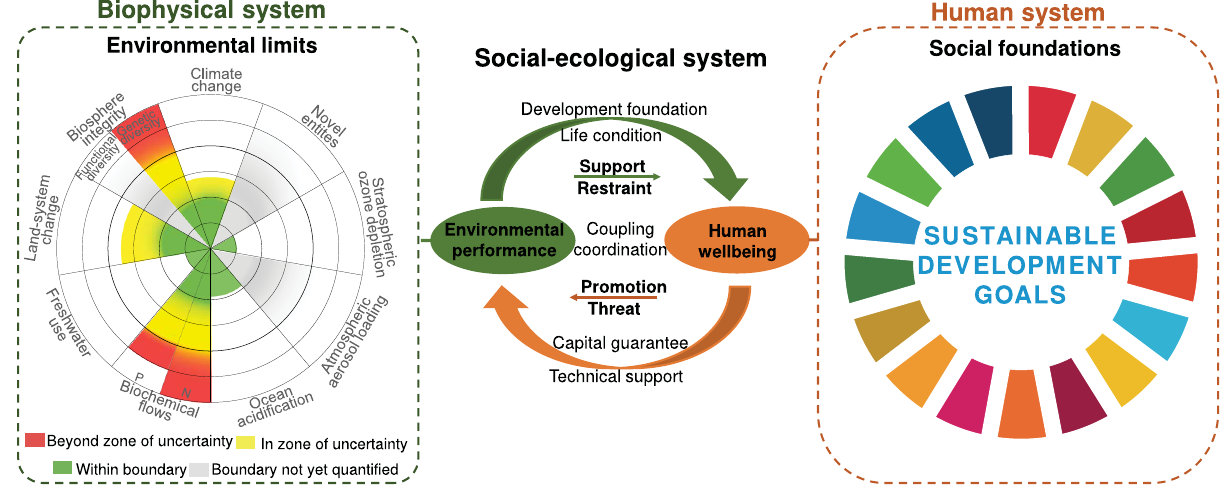
Fig. 1 | Conceptual framework of the coupling coordination relationships between environmental performance and human well-being. The framework integratesthesafeandjustoperatingspaceandfootprint-boundaryframeworksto measure the sustainability related to the corresponding SDGs within a coupled social-ecological system. Human well-being indicators (social foundations within